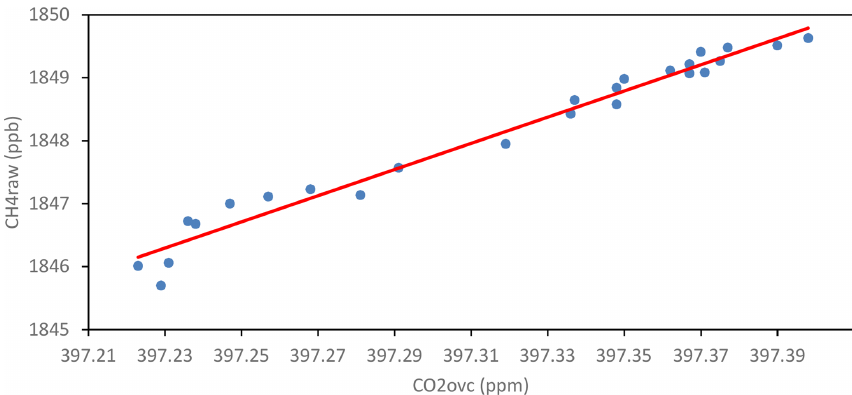
Figure 5. Scatter plot of CH4raw vs. CO2raw for the mentioned virtual tank. The red line has been obtained performing a least-square fitting of the data to a linear